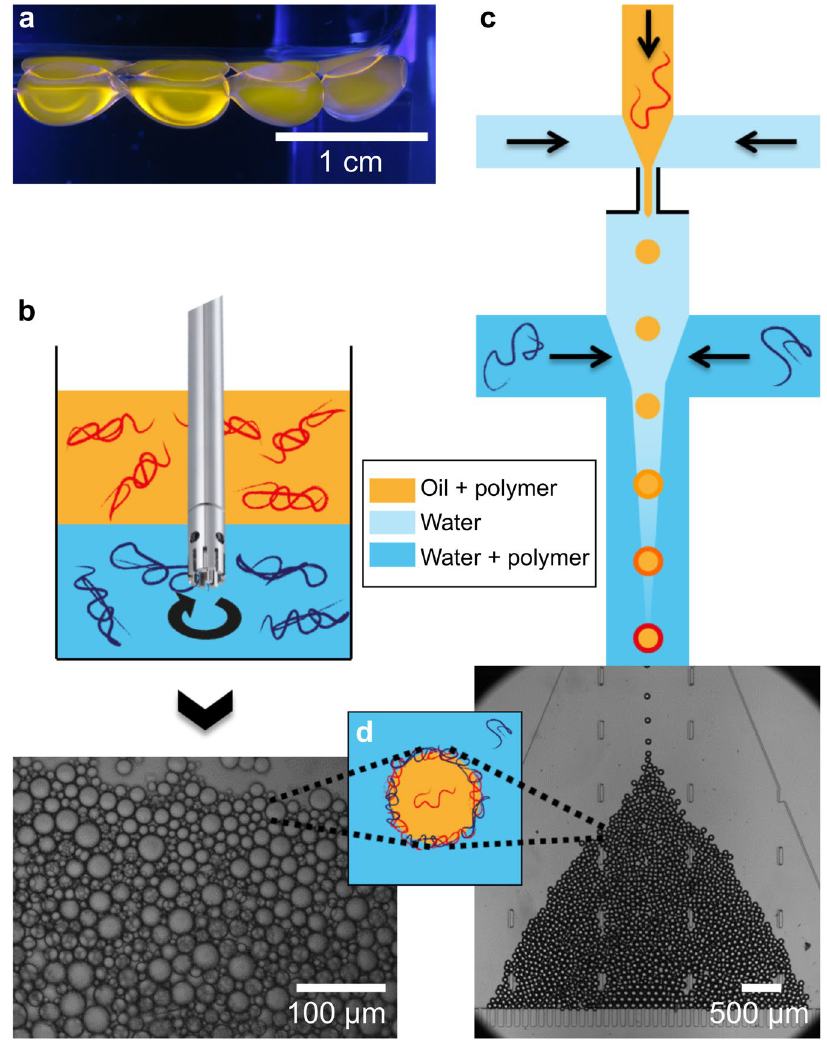
Figure 3. Three ways to build multi-sized capsules that remain stable over time. ( a ) Centimetric capsules made by gentle injection of one phase into the other. ( b ) Top: schematic of emulsification performed by a rotor-stator homogenizer in a centimetric vial. Bottom: microscope observation of the obtained emulsion containing polydisperse micron-sized capsules. ( c ) Top: schematic of the microfluidic device used to form capsules in a single step. Oil with PPO is injected in pure water through a flow-focusing unit which forms monodisperse droplets. Water with PMAA is injected after the constriction to avoid early complexation. PMAA diffuses to the water-drop interface, thus leading to the membrane formation. Bottom: microscope observation of the capsules trapped in the chamber by a filter. ( d ) Schematic of a capsule whose membrane formed by interfacial complexation is stable over